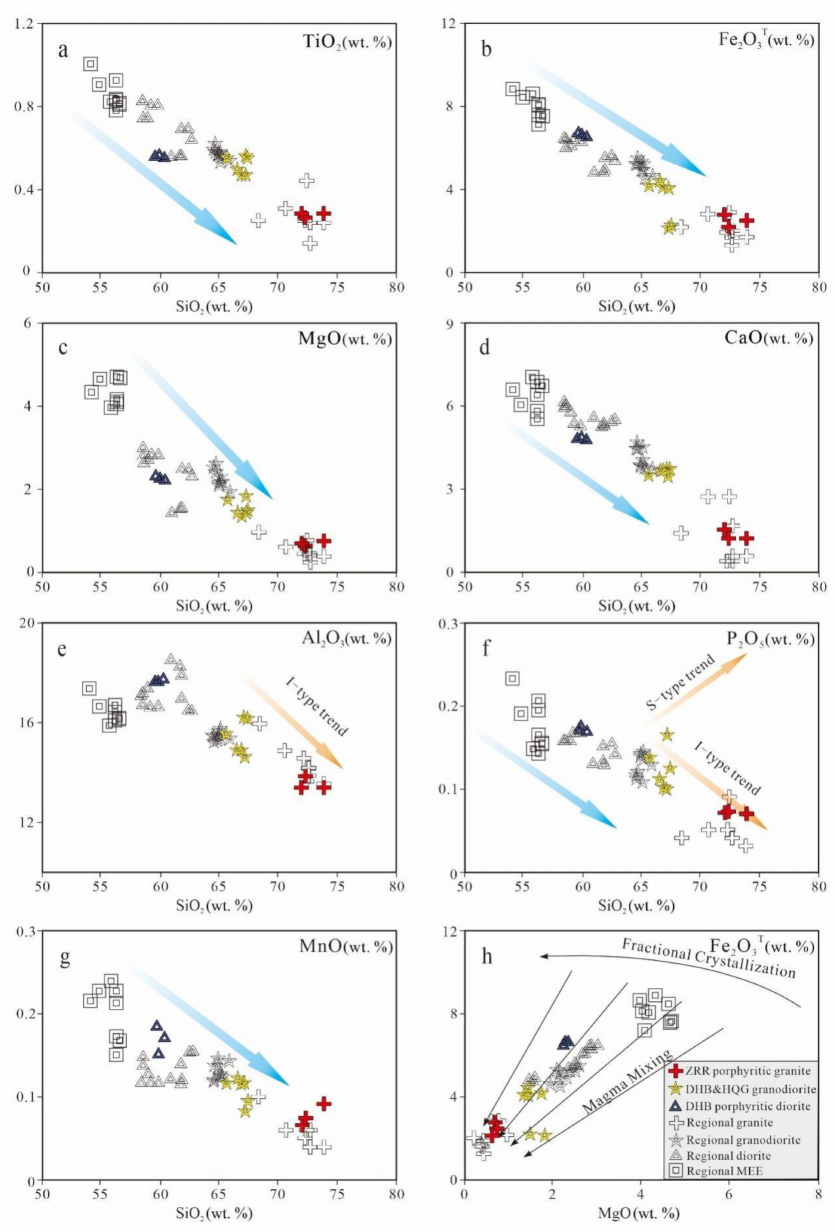
Figure 10. ( a – g ) Harker diagrams for the Triassic igneous rocks in the Ela Mountain area; ( h ) MgO versus Fe 2 O 3T diagram [45]. The sources of published data are the same as those in Figure